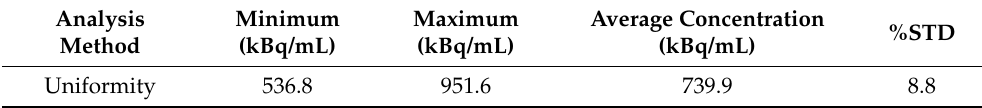
Figure 9. The 3D-MLEM reconstructed PET transverse images of NEMA standard IQ phantom. ( a ) The uniformity region, ( b ) five rods, and ( c ) two-chamber region. Table 2. The calculated uniformity values.